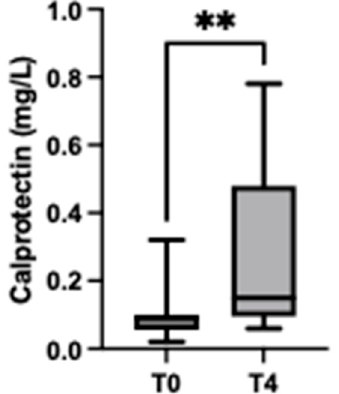
Figure 4. Concentrations of calprotectin in pigs at the arrival to the slaughterhouse (T0) and 4 h after transportation (T4). The plots show medians (line within box), 25th and 75th percentiles (boxes) and min and max values (whiskers). ** p -value < 0.01.